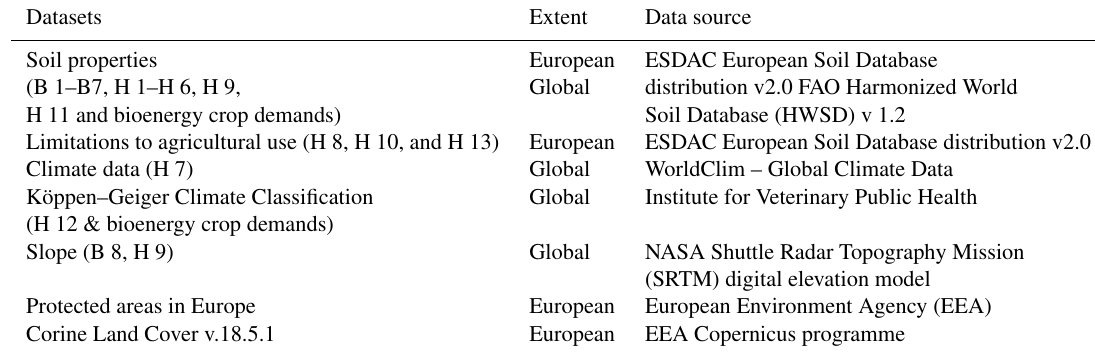
Table 4. Overview of geospatial datasets used and corresponding sources needed for SQR basic and hazard indicator valuation (B 1–8; H